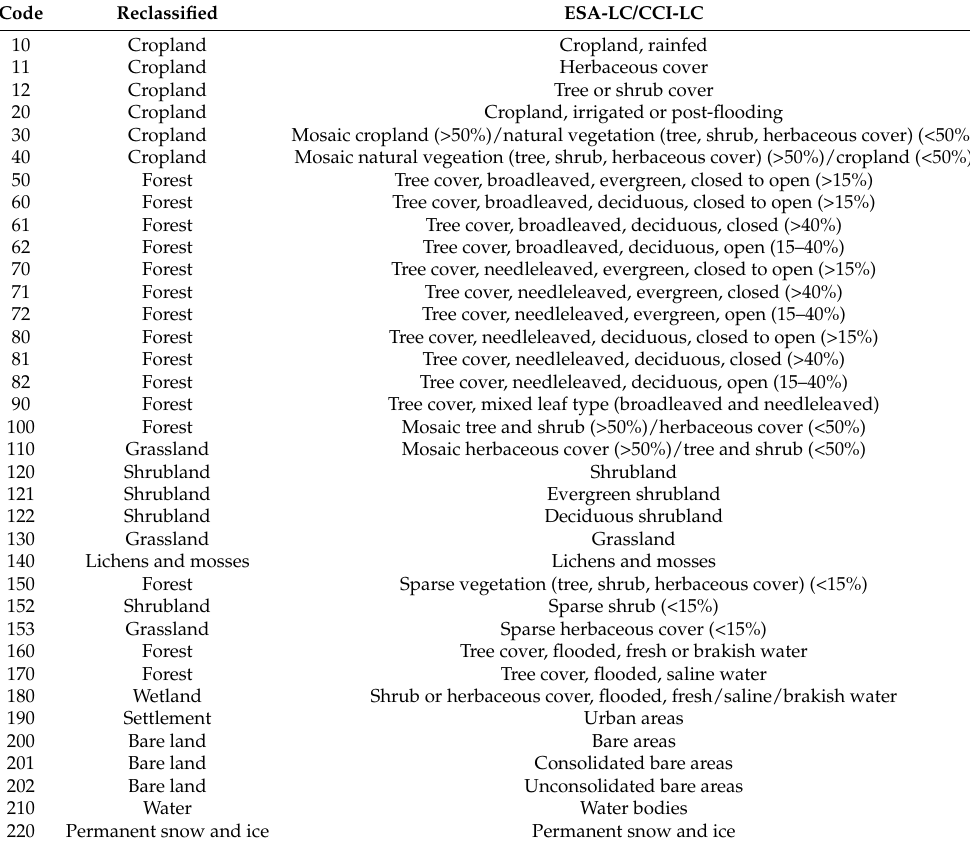
Table 3. Mapping table for reclassifying ESA landcover’s 22 land classes into 10 reclassified land classes consistent with